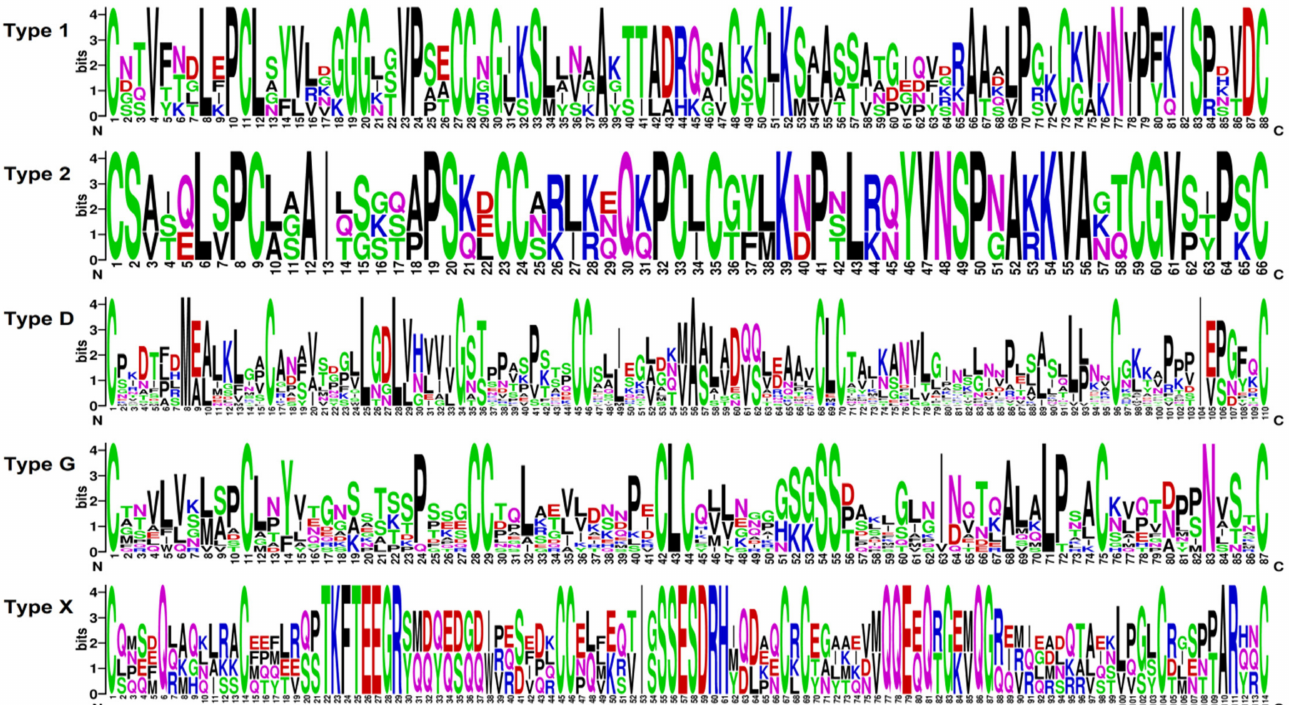
Figure 3. Sequence logo plots of aligned 8-cysteine motif sequences for each SlLTP type. The numbers on the x-axis represent the positions in the 8-cysteine motif. On the y-axis, the information content measured in bits is